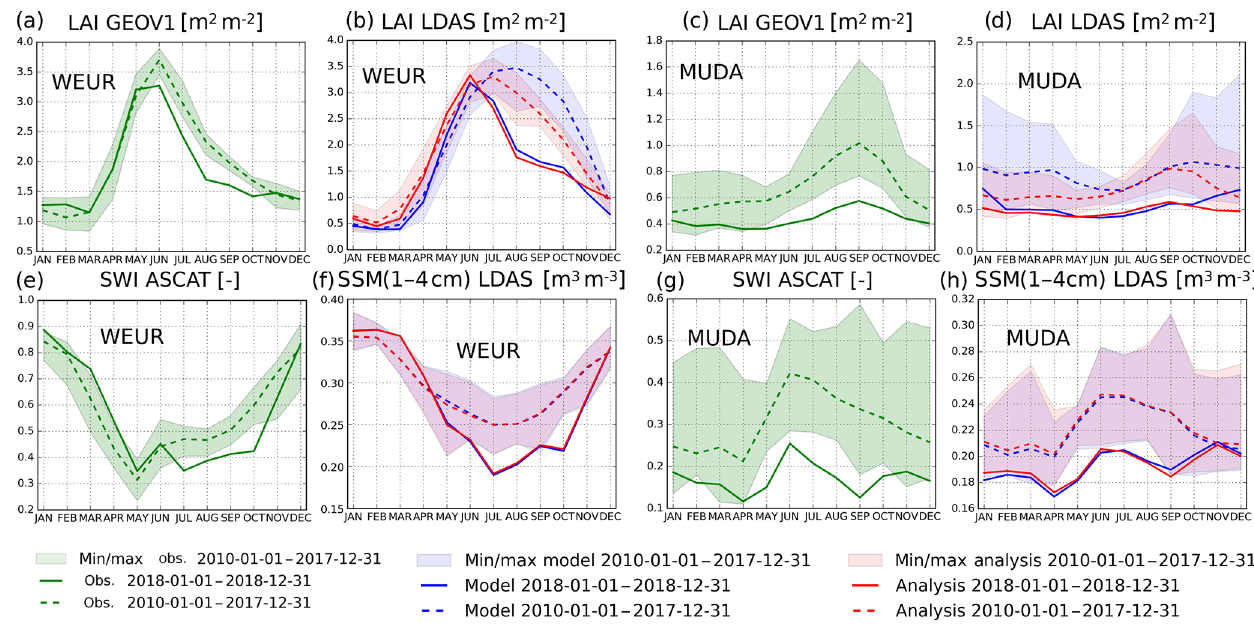
Figure 11. Upper panels represent seasonal cycles of (a) observed GEOV1 LAI from CGLS and (b) LAI from the open-loop (in blue) and the analysis (in red) for the WEUR area (see Table 1 for geographical extent). Panels (c) and (d) are similar to (a) and (b) for the MUDA area. Lower panels represent seasonal cycles of (e) ASCAT SWI from CGLS and (f) SSM from the open-loop (in blue) and the analysis (in red) for the WEUR area. Panels (g) and (h) are similar to (e) and (f) for the MUDA area. For each panel dashed line represents the average over 2010–2017 along with the minimum and maximum values; the solid lines are for the year